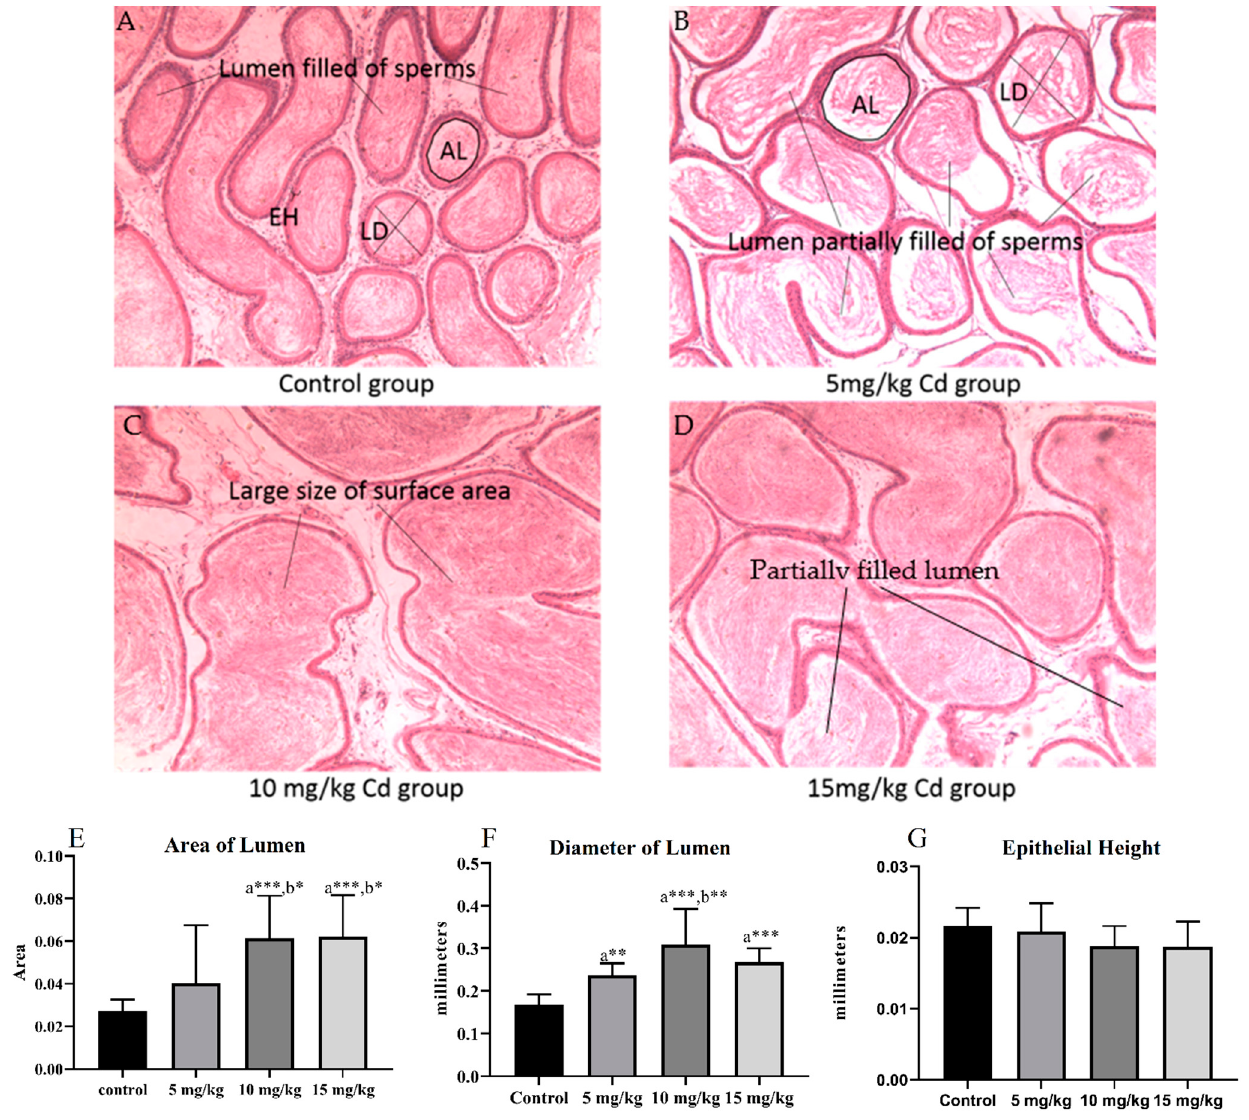
Figure 3. Microphotographs of the epididymis. ( A ) The control group showed normal morphology and lumen full of sperm. ( B ) The 5 mg Cd/kg treatment group showed damaged tubules with a partially empty lumen. ( C ) The 10 mg Cd/kg and ( D ) 15 mg Cd/kg treatment groups showed lumen with a large surface area. The ( E ) area and ( F ) diameter of the lumen. ( G ) Height of the epithelium (magnification 10 × ). (a = comparison to control, b = comparison to 5 mg/kg group. Probability: * = p < 0.05, ** = p < 0.01 and *** = p < 0.001)